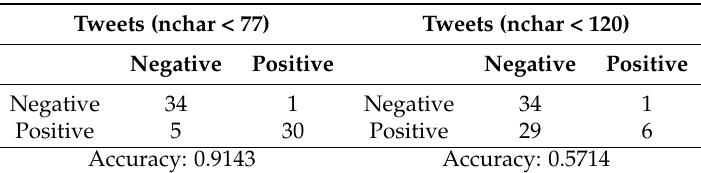
Table 6. Naïve Bayes classification by varying Tweet